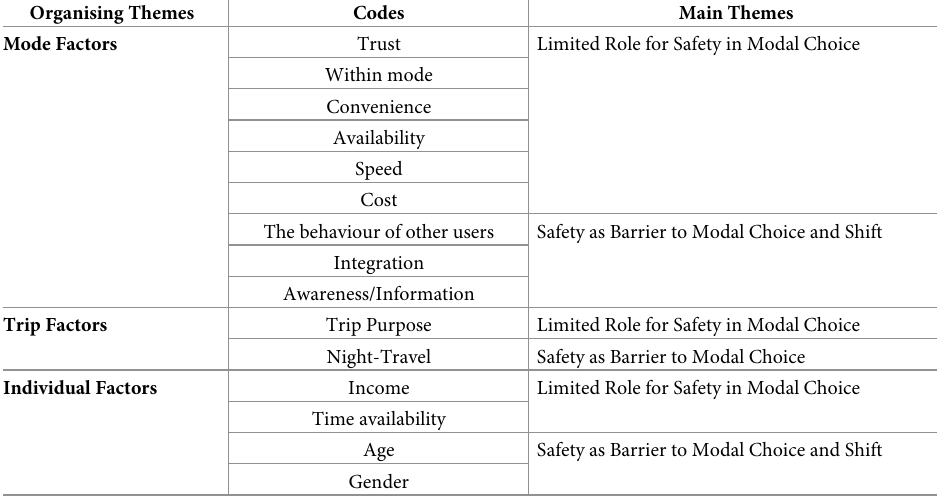
Table 3. Organising themes, codes and main themes related to modal choice shift and travel